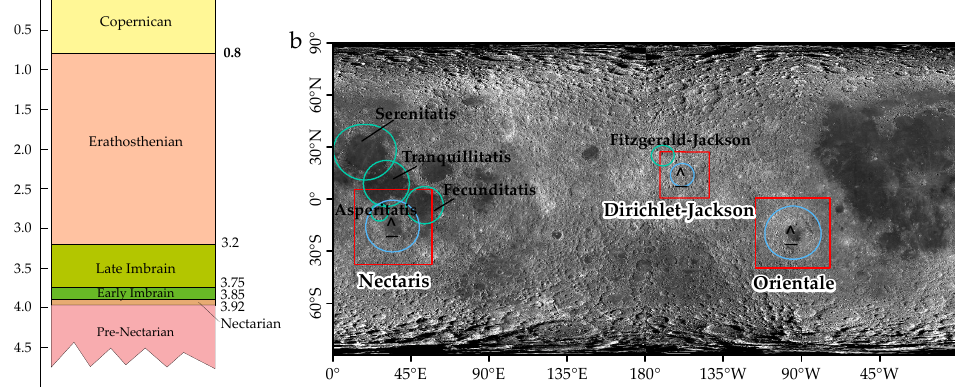
Figure 1. ( a ) Geologic time scale of the Moon revised by Stöffler et al. [13]. ( b ) LRO WAC Global Mosaic (resolution 100 m/pixel) showing the locations of three study areas surrounding the selected basins. The map is displayed in simple cylindrical projection.